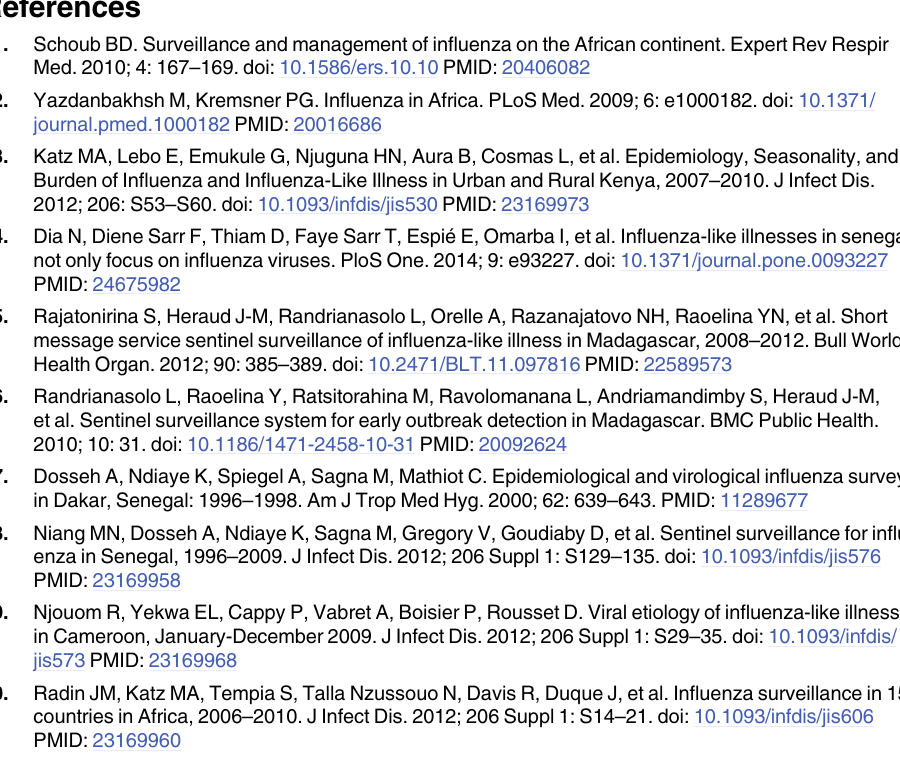
S1 Table. Annual incidence rates according to age group and village (episodes per 100